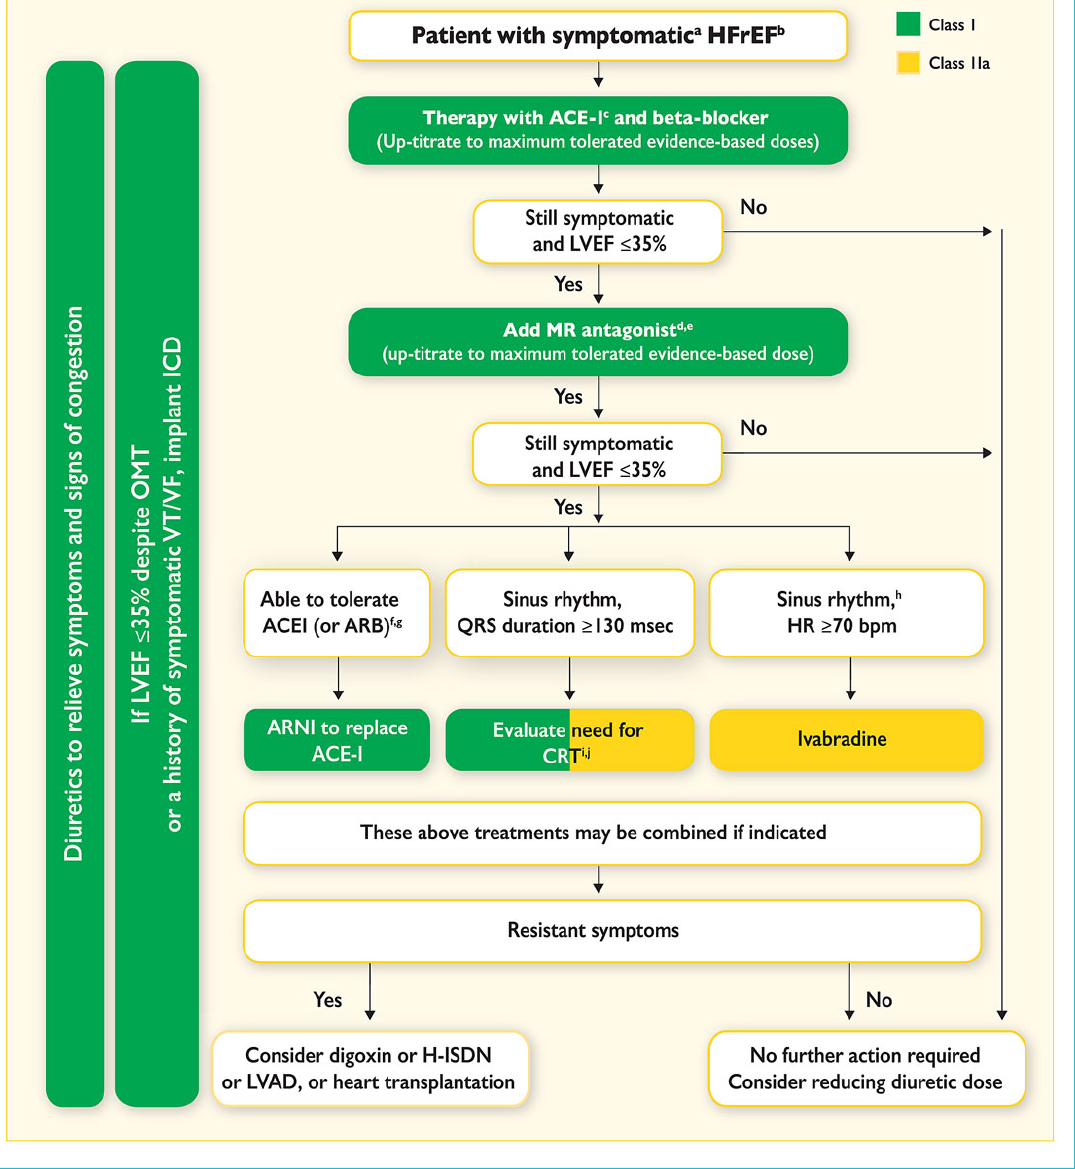
Table 2 provides both GPs and cardiologists with a check- list for initiating and up-titrating HF medication. An overview is depicted in figure 1. This up-titration strategy Management of adverse events is part of the up-titration should be followed in all HFrEF patients as long as the strategy. Patients with asymptomatic hypotension (systolic therapy is tolerated. The up-titration strategy should be ad- justed in the case of adverse events such as hypotension, hyperkalaemia or worsening renal function [1, 30]. Rec- Figure 2: Treatment algorithms of symptomatic HFrEF patients [1]. ACEI = angiotensin-converting enzyme inhibitor; ARB = angiotensin II receptor blocker; ARNI = angiotensin receptor neprilysin inhibitor; CRT = cardiac resynchronisation therapy; HFrEF = heart failure with re- duced ejection fraction; H-ISDN = hydralazine and isosorbide dinitrate; HR = heart rate; ICD = implantable cardioverter defibrillator; LVAD = left ventricular assist device; LVEF = left ventricular ejection fraction; MR = mineralocorticoid receptor; OMT = optimal medical therapy; VF = ventricular fibrillation; VT = ventricular tachycardia. a Symptomatic = NYHA Class II-IV. b HFrEF = LVEF <40%. c If ACEI not tolerated / con- traindicated, use ARB. d If MR antagonist not tolerated / contraindicated, use ARB. e With a hospital admission for HF within the last 6 months or with elevated natriuretic peptides (BNP >250 pg/ml or NTproBNP >500 pg/ml in men and 750 pg/ml in women). f With an elevated plasma natriuretic peptide level (BNP ≥150 pg/ml or plasma NT-proBNP ≥600 pg/ml, or if HF hospitalisation within recent 12 months plasma BNP ≥100 pg/ml or plasma NT-proBNP ≥400 pg/ml). g In doses equivalent to enalapril 10 mg b.i.d. h With a hospital admission for HF within the pre- vious year. I CRT is recommended if QRS ≥130 msec and LBBB (in sinus rhythm). j CRT should/may be considered if QRS ≥130 msec with non-LBBB (in a sinus rhythm) or for patients in AF provided a strategy to ensure bi-ventricular capture in place (individualised decision). Adapted from Ponikowski P, Voors AA, Anker SD, Bueno H, Cleland JGF, Coats AJS, et al.; ESC Scientific Document Group. 2016